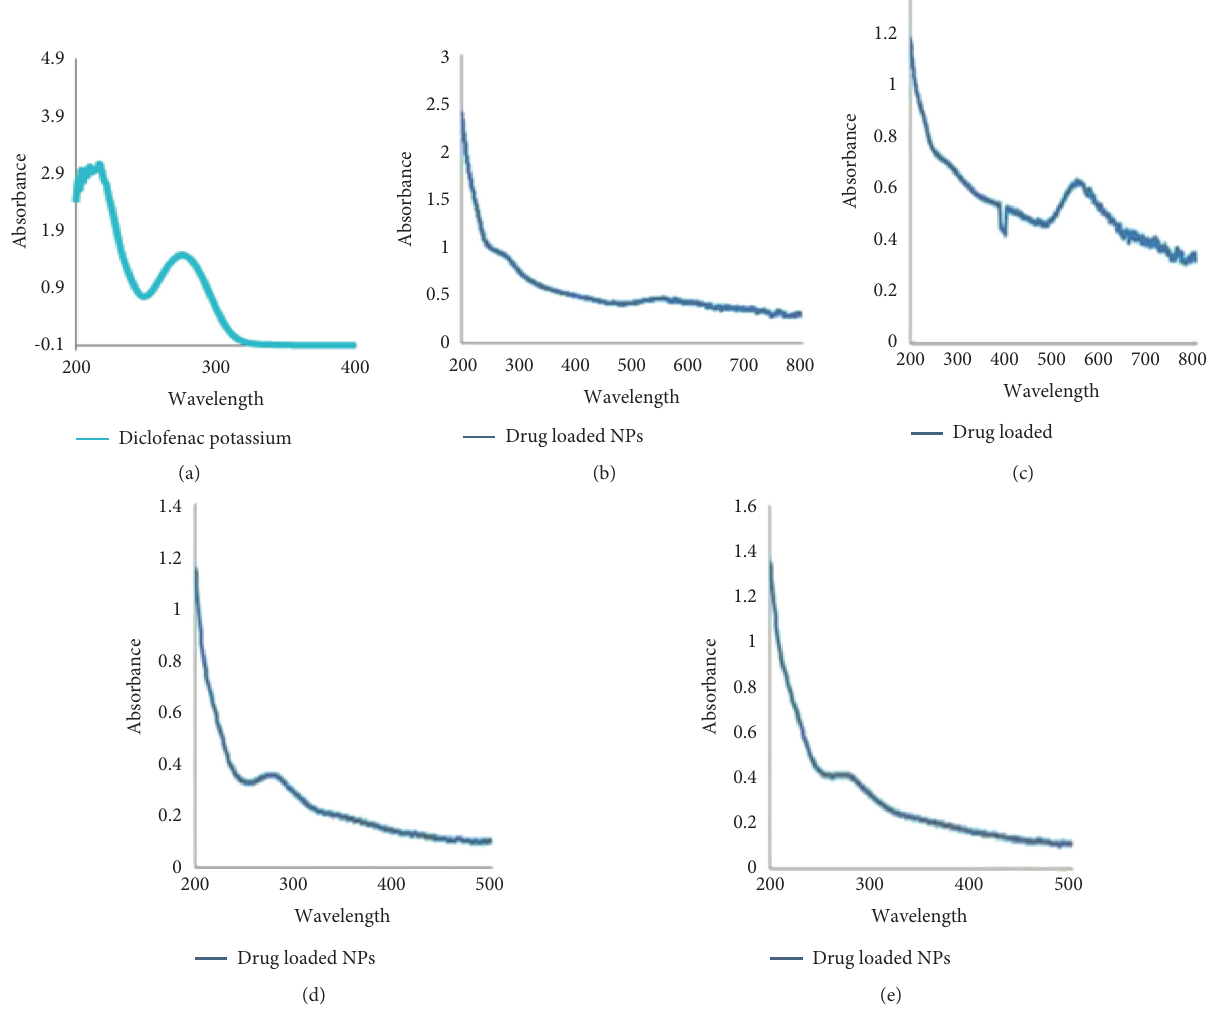
Figure 4: UV-visible spectra of diclofenac potassium and drug-loaded nanoparticles of (a) diclofenac potassium (DFP), (b) Syzygium cumini AuNPs, (c) Ficus microcarpa AuNPs, (d) Syzygium cumini FeNPs, (e) Ficus microcarpa